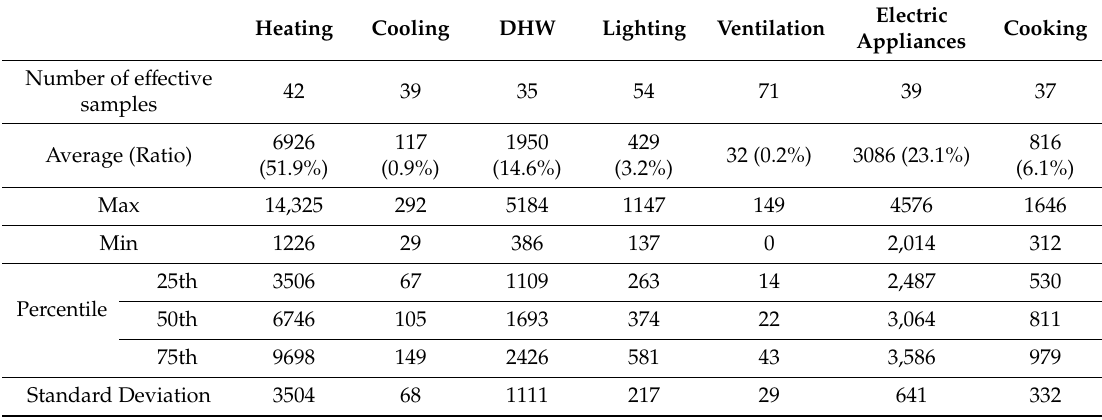
Table 2. Annual end-use energy-consumption statistics (unit: kWh /